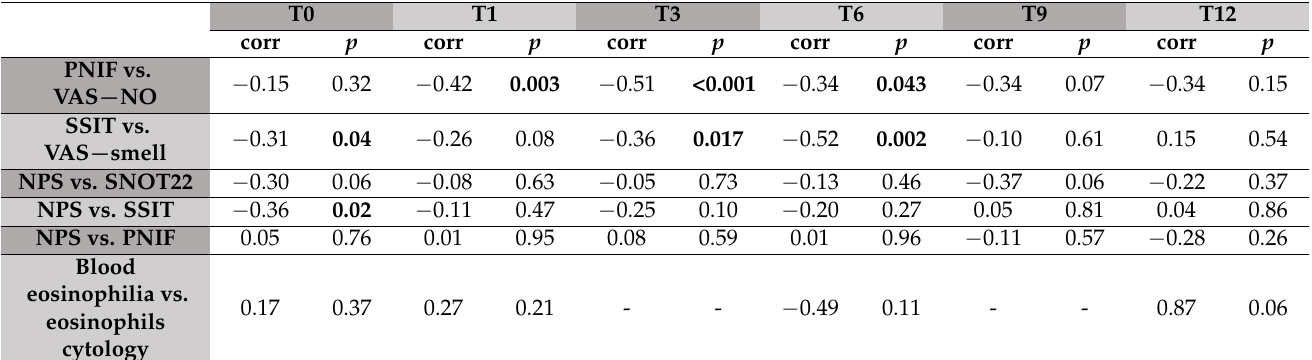
Figure 2. Objective parameter changes during the treatment. NPS: Nasal Polyp Score; PNIF: Peak Nasal Inspiratory Flow; SSIT: Sniffin’ Sticks Identification Test; m: months. Table 3. Correlations between objective measurements and symptoms during the study